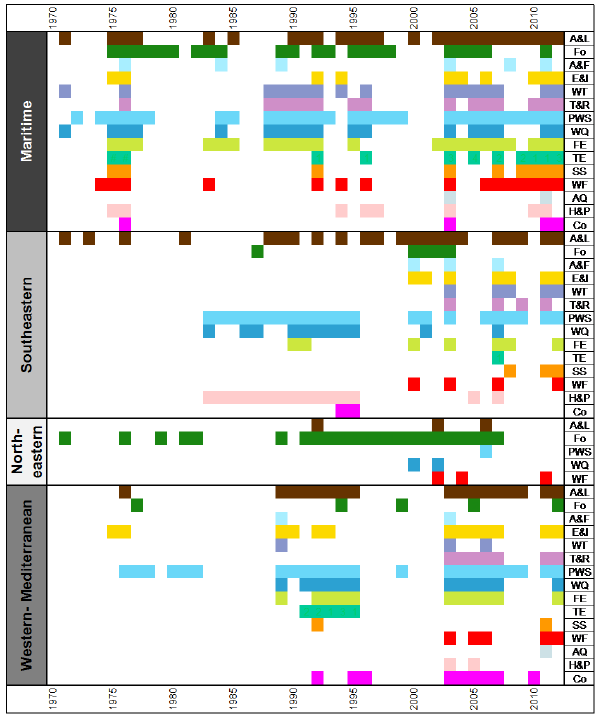
Figure 2. Annual drought impact occurrence by European macro region and impact categories. A&L: Agriculture and Livestock Farming, Fo: Forestry, A&F: Aquaculture and Fisheries, E&I: En-